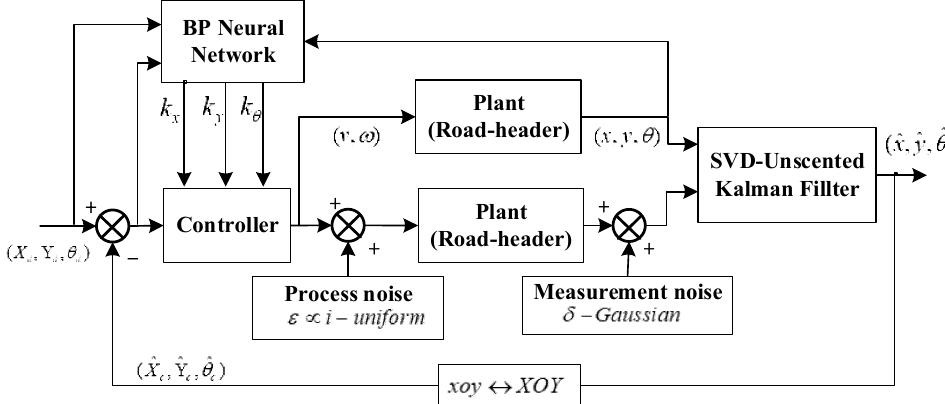
Figure 10. Framework of the proposed path tracking combining state estimation and BP neural network.